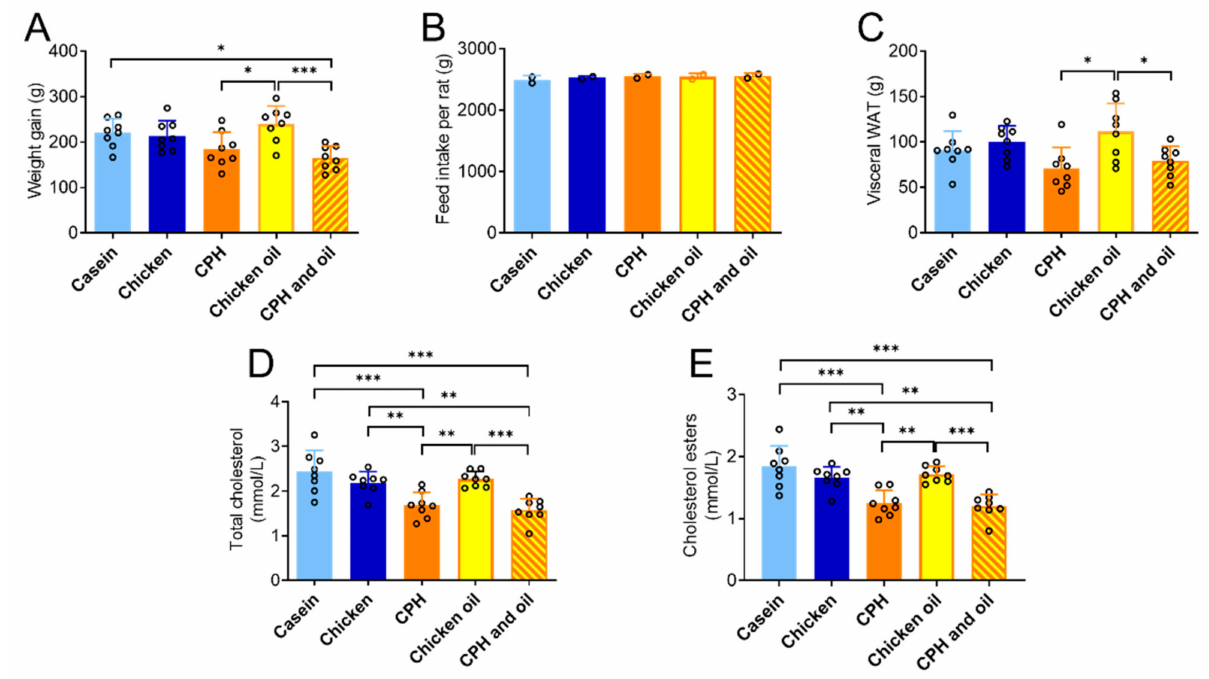
Figure 5. The effect of chicken oil, or a combination of chicken protein hydrolysate (CPH) and chicken oil on ( A ) weight gain, ( B ) total feed intake, ( C ) sum of visceral white adipose tissue (WAT) weights, ( D ) plasma total cholesterol and ( E ) cholesterol esters in Wistar rats. Means values with standard deviation are given, and individual values are indicated by circles ( n = 7–8). One-way ANOVA with Tukey’s multiple comparisons test between all diet groups (* p < 0.05, ** p < 0.01, *** p <